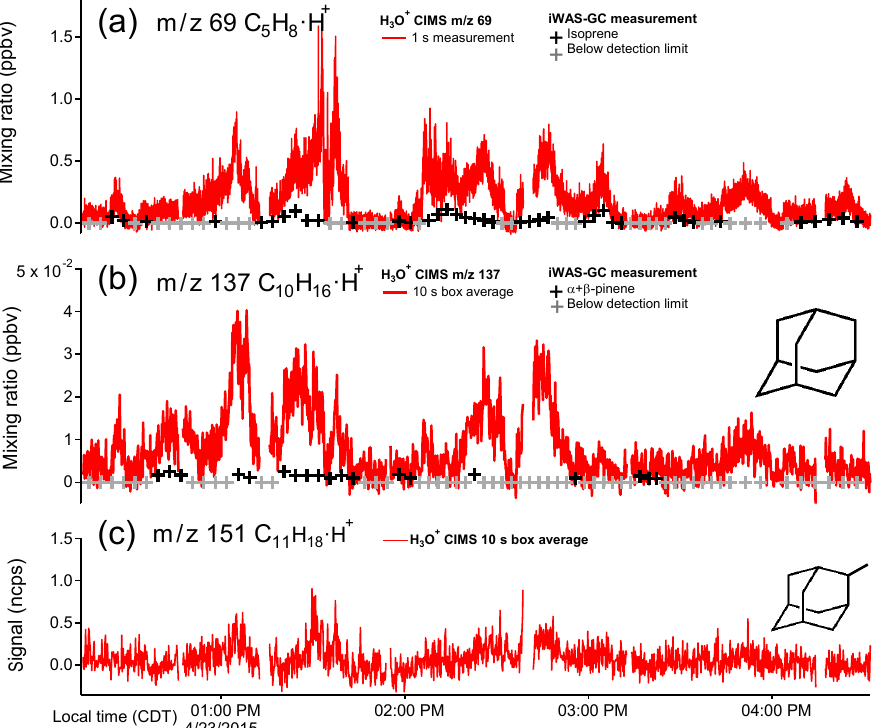
Figure 10. Time series of hydrocarbon masses. (a) m/z 69 C 5 H + , converted toppb using isoprene sensitivity. (b) m/z 137 C 10 H 16 H + , 9 converted toppb using monoterpenes sensitivity. (c) m/z 151 C 11 H 18 H + , in ncps. The structures of adamantane and a methyl adamantane isomer (both isomers exist in oil) are included in panels (b) and (c) , respectively.